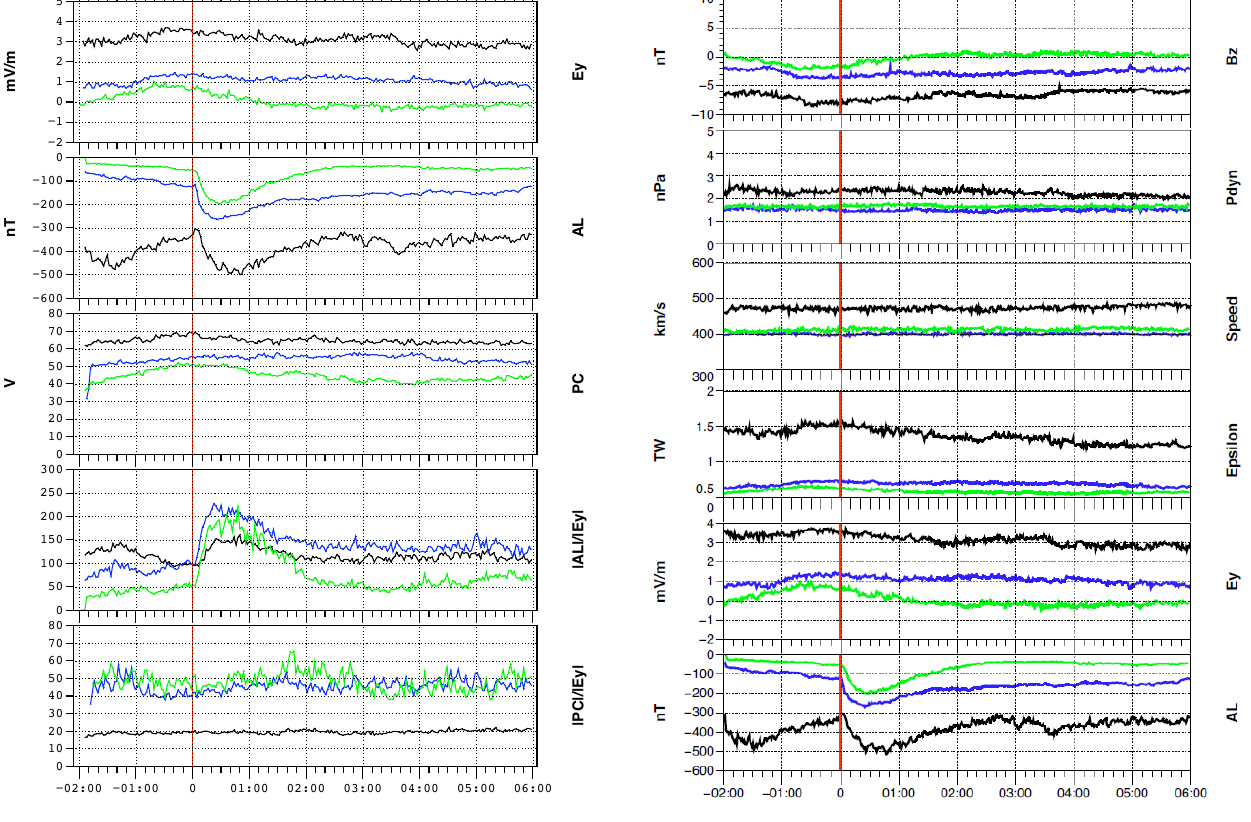
Fig. 5. Superposed epoch curves for the full sets of sawtooth events (black), SMC periods (blue), and isolated substorms (green). The panels from top to bottom are: IMF B Z , solar wind dynamic pres- sure, solar wind speed, epsilon parameter, solar wind motional elec- tric field, and AL